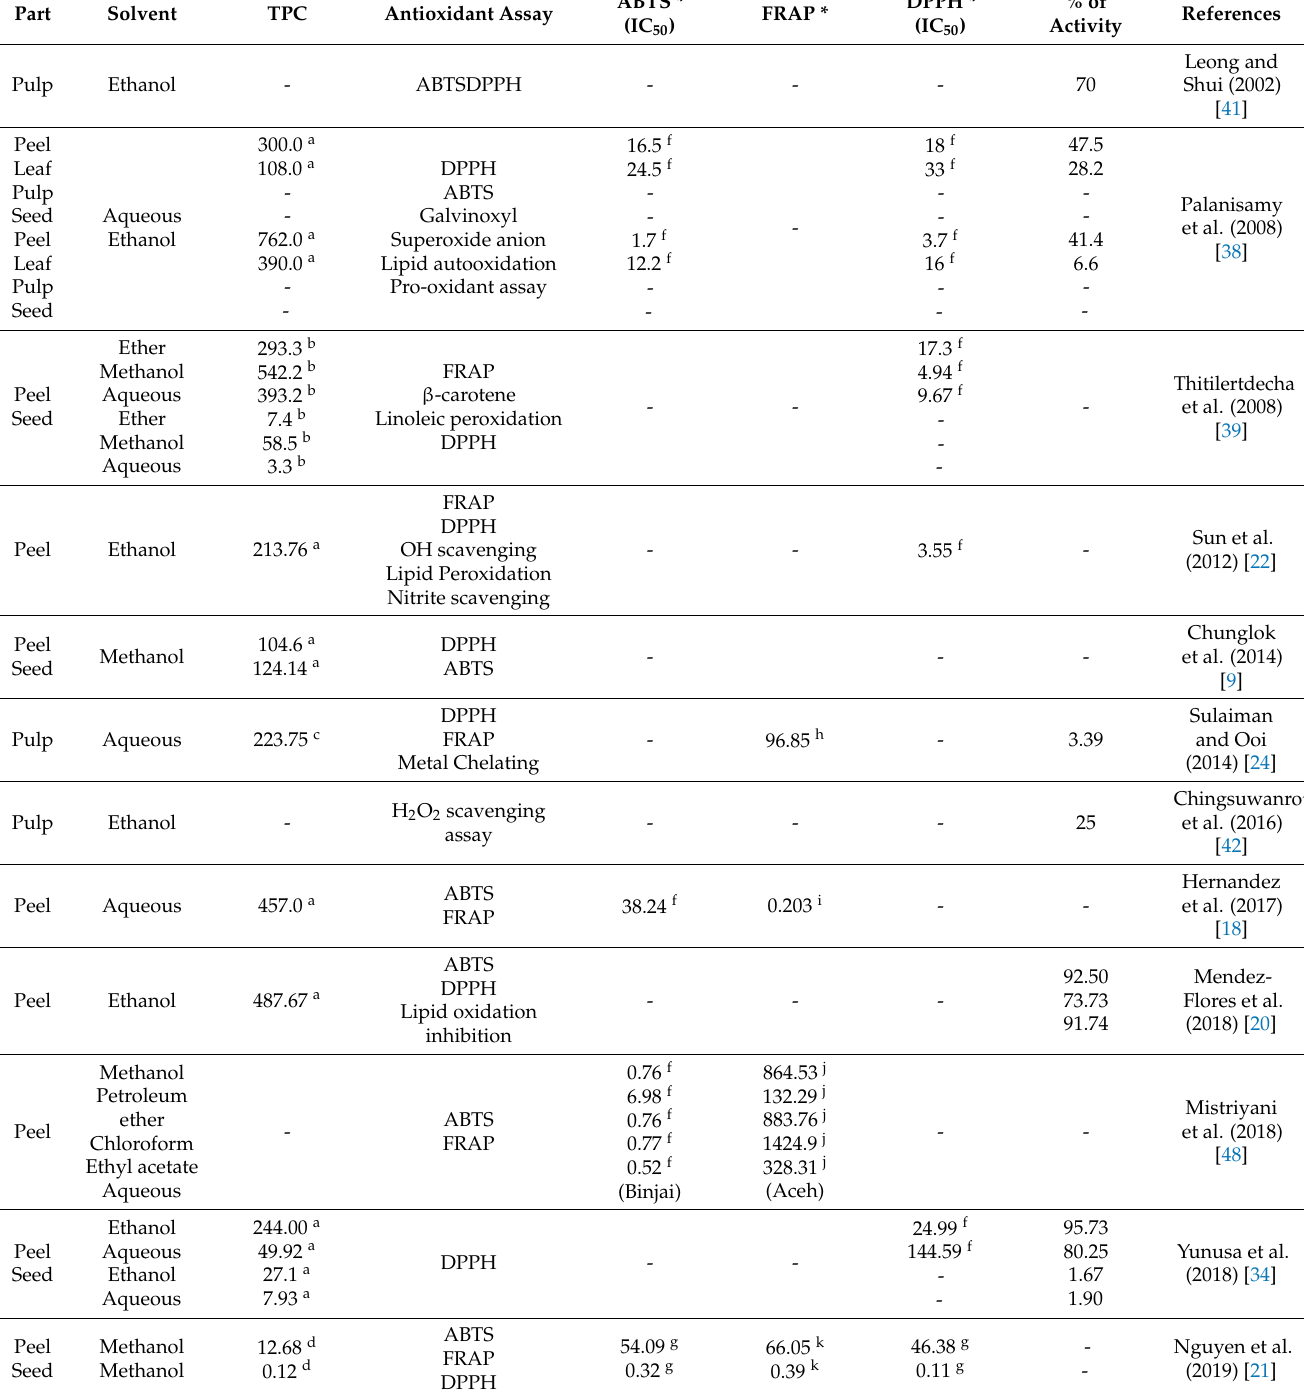
Table 4. List of antioxidant assays performed on N. lappaceum